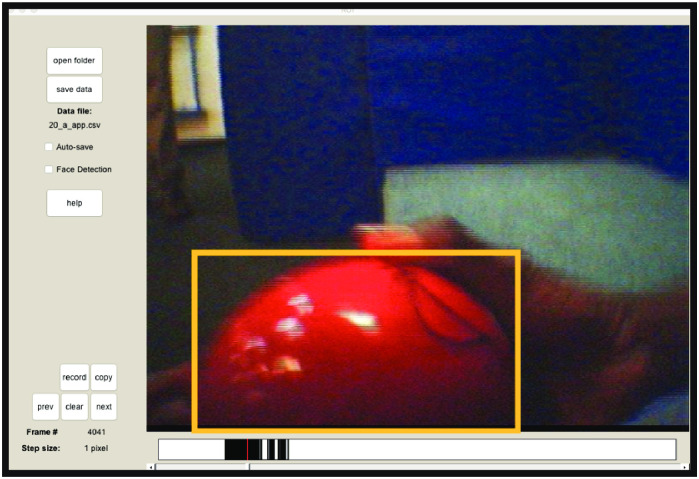
Dynamic ROI coder.Coders used the Matlab program Dynamic ROI Coder to draw a box around the toy in each frame of infants’ field of view video.